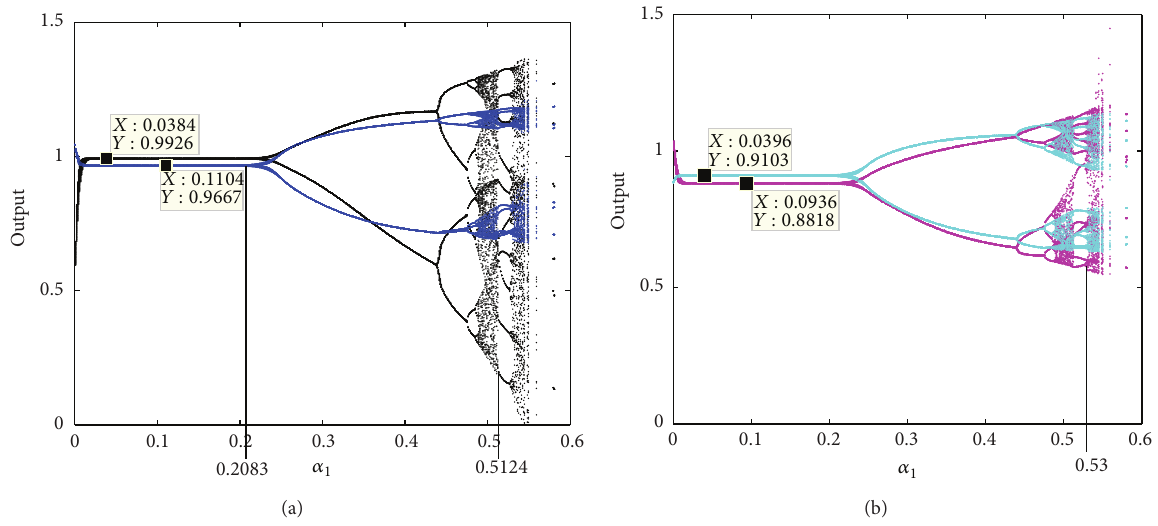
Figure 2: The bifurcation diagram with 𝑘 = 0.2 , 𝑟 = 1.6 , 𝛼 2 = 𝛽 1 = 𝛽 2 = 0.34 .